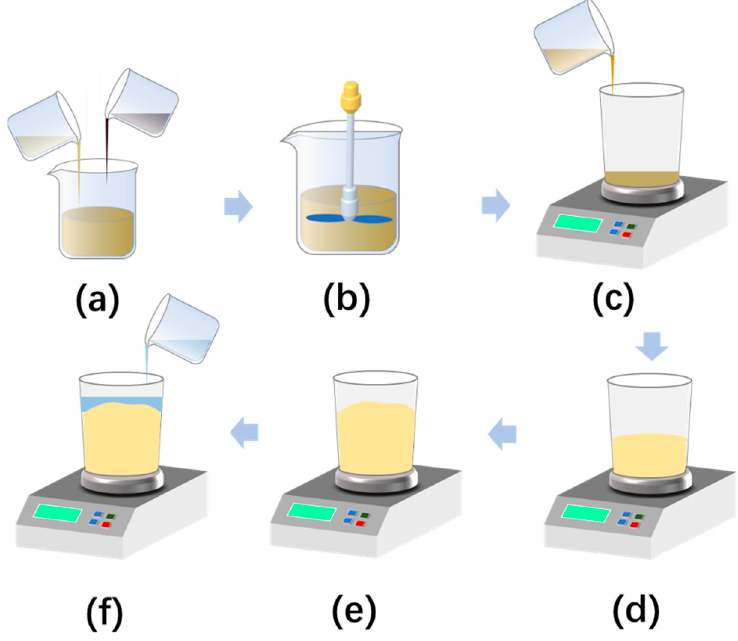
Figure 1. The method of adding water to compensate for the difference is described as follows: ( a ) add A-side and B-side; ( b ) mix and stir; ( c ) transfer the mixture into a large beaker for foaming; ( d ) perform PURF foaming; ( e ) complete the foam molding process; ( f ) add water to fill any voids. The real volume of PURF can be calculated using Equation